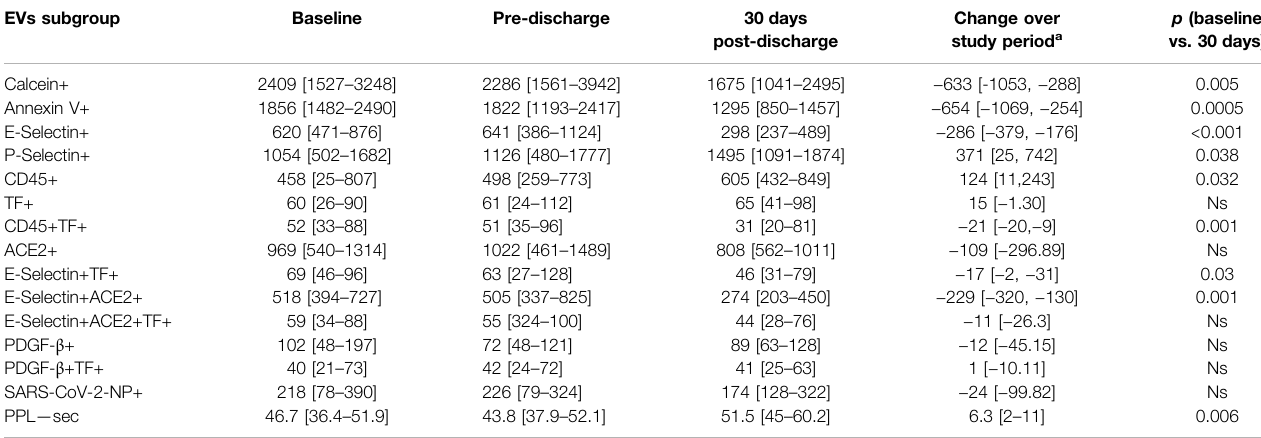
TABLE 4 | EVs levels in the study population.